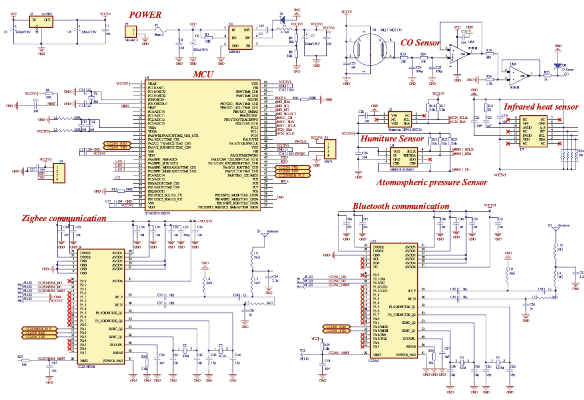
Figure 7: Circuit diagram of the master control